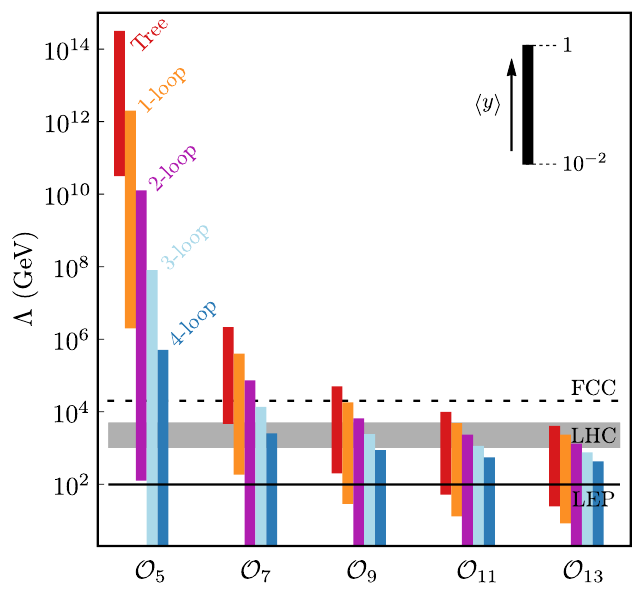
Figure 1 . The typical energy scales ((cid:3)) for which a neutrino mass model with a given dimension and number of loops ( d; n ) can explain correctly the observed sub-eV neutrino masses. Operators start at d = 5, corresponding to the Weinberg operator. Energy ranges have been estimated using average couplings h y i in the range of [0 : 01 ;